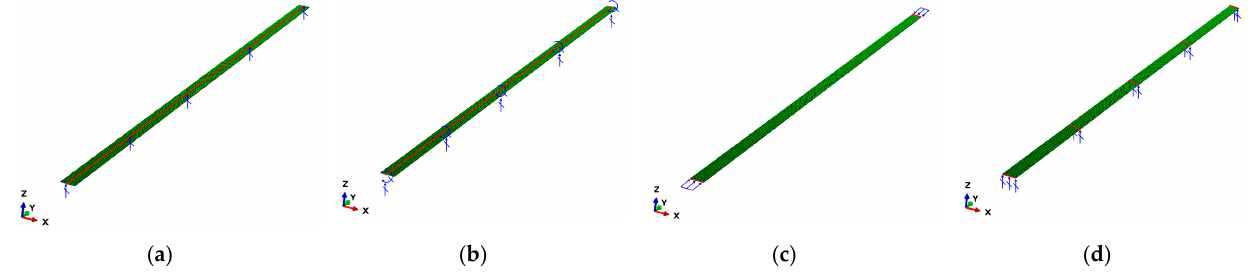
Figure 8. Compressive load and boundary conditions. ( a ) Hinge supports: displacement constrains along the Z -axis; ( b ) fixed supports: displacement constraints along the Z -axis and rotations along the Y -axis; ( c ) uniform loads at each end for the hinge and fixed condition; and ( d ) support along the Z -axis for the hinge and fixed conditions .